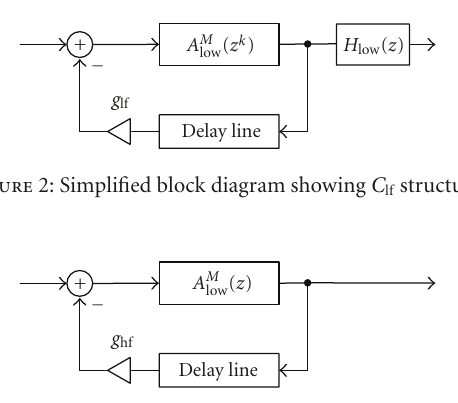
Figure 3: Simplified block diagram showing C hf